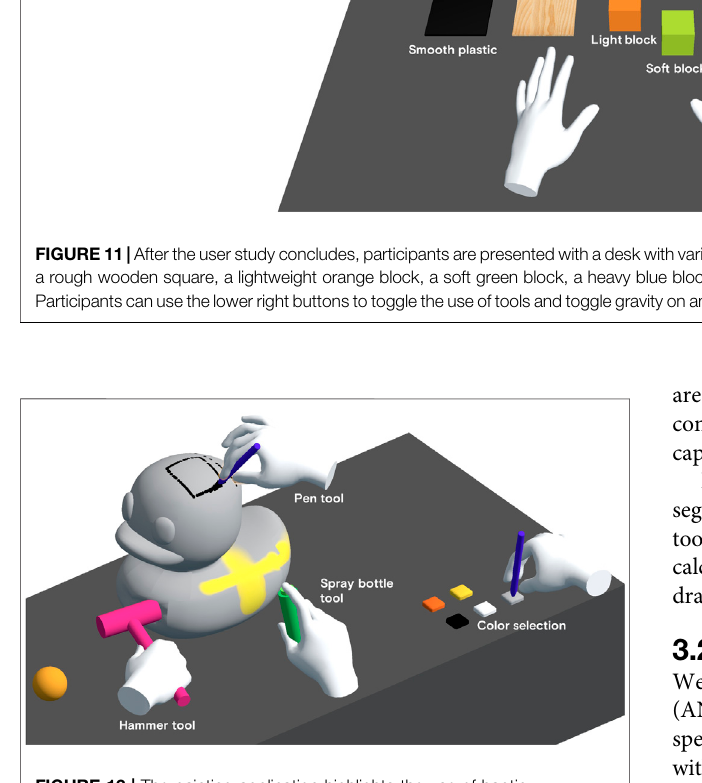
FIGURE 12 | The painting application highlights the use of haptic feedback to enhance the experience of using otherwise passive tools in the hand.Shown arefour interactionsoverlaid from left toright: using the hammer tooltoadjustthesculpture ’ sgeometry,usingthepentooltodrawonthe sculpture, using the spray bottleto spray paint on the sculpture, and selecting colors by tapping the tools on the swatches provided. Haptic feedback provided by the tools is visualized in Figure 7